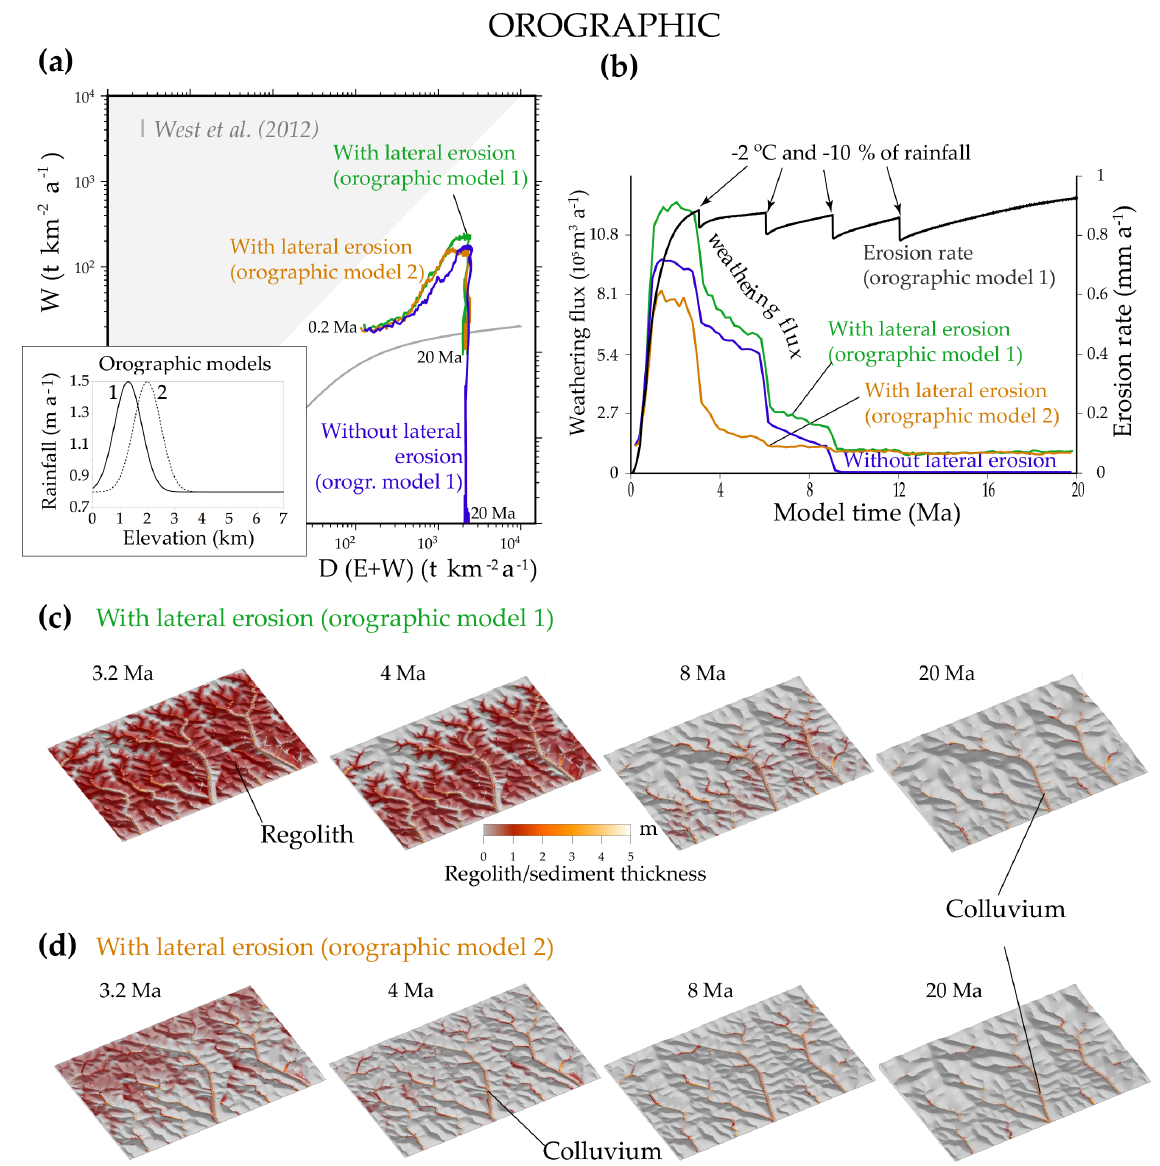
Figure 8. OROGRAPHIC experiment. A orographic-like precipitation peak is considered in addition to the parameters of the previous COOLING experiment. The erodibility coefficients are doubled in order to obtain comparable maximum elevations ( K and κ in Eq. 2). (a) Denudation–weathering evolution with and without lateral erosion for two orographic models with peaks at 1300 or 2000m of elevation. (b) Erosion and weathering flux through time for the two orographic models. (c) Elevation and regolith or sediment cover evolution for the orographic model 1 with lateral erosion ( α = 0.001). (d) The same for orographic model 2. The regolith legend applies to (c) and (d)